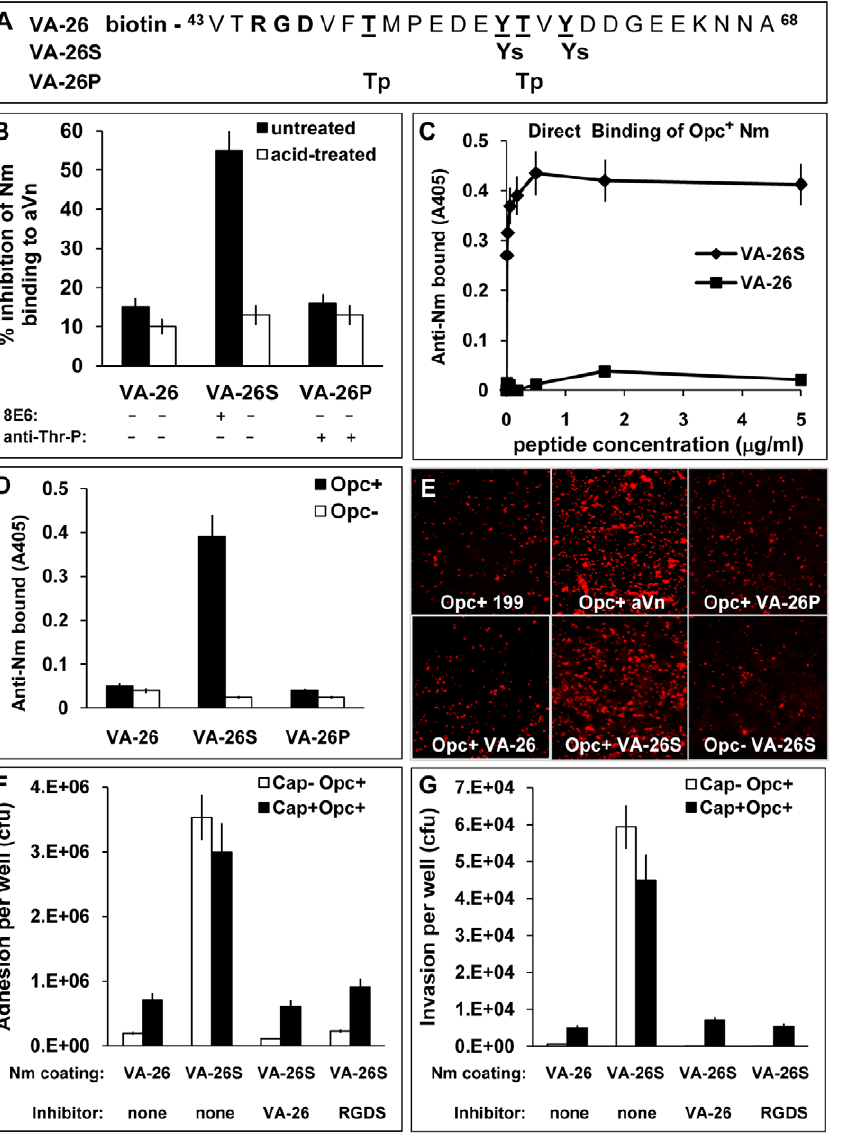
Figure 6. The VA-26S sulphated peptide contains the features required and sufficient for Opc binding and cellular invasion. (A) Structures of the biotinylated peptides spanning the Vn region 43–68. VA-26 peptide was unmodified other than at the N-terminal residue which was linked to biotin. Additionally, VA-26S contained sulphated Y 56 and Y 59 and VA-26P contained phosphorylated T 50 and T 57 . (B) Using 25 m g/ml each of untreated and prior acid-hydrolysed peptides, their relative abilities to inhibit C751 Opc + bacterial interactions with immobilised aVn were examined by ELISA. Only untreated VA-26S inhibited bacterial binding to aVn. The table summarises the effect of acid-treatment on the peptides (see Figure S1), only the sulphated residues are hydrolysed and consequently only the mAb 8E6 binding to VA-26S is affected after treatment. (C) To examine the direct binding of Opc + Nm of strain C751 to VA-26S and VA-26, the peptides were first immobilised on extravidin-containing plates (Figure S2). Bacterial binding was detected using anti-Nm antiserum. Opc + Nm bound significantly only to VA-26S. (D) Relative levels of direct binding of Opc + and Opc 2 Nm to immobilised VA-26, VA-26S and VA-26P peptides by ELISA. In each case, saturating levels of peptides were used (5 m g/ml each, Figure S2). Bacterial binding as detected using anti-Nm antiserum shows only VA-26S and Opc + Nm interactions. (E) Immunofluorescence analysis of the ability of VA-26 peptides, which contain the integrin-binding domain RGD, to mediate bacterial binding to HBMECs. Opc + bacteria but not Opc 2 bacteria localised on to HBMECs in significantly higher numbers in the presence of VA-26S (and aVn control) but not with other peptides (all used at 20 m g/ml). (F and G) To assess the efficacy of VA-26S in mediating acapsulate and capsulate bacterial adhesion and invasion, viable count experiments were performed using VA-26 or VA-26S peptide-coated bacteria. In some experiments VA-26 (20 m g/ml) and RGDS (0.25 mM) were used to preincubate HBMECs to act as inhibitors of RGD-mediated binding of VA-26S-coated bacteria. The data illustrate that two key features (sulphated tyrosines and RGD) present in VA-26S are required and sufficient for mediating bacterial invasion of